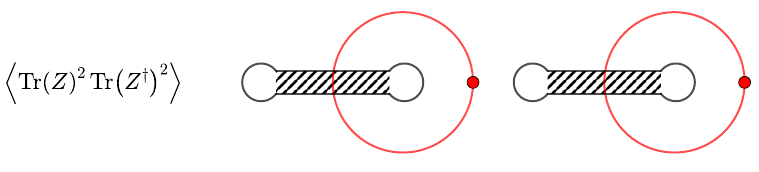
Figure 1 . The original ribbon graph is in black. The (cid:26) graph is in